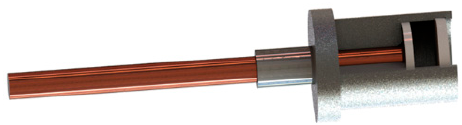
Figure 3. Structure of the sensor probe.